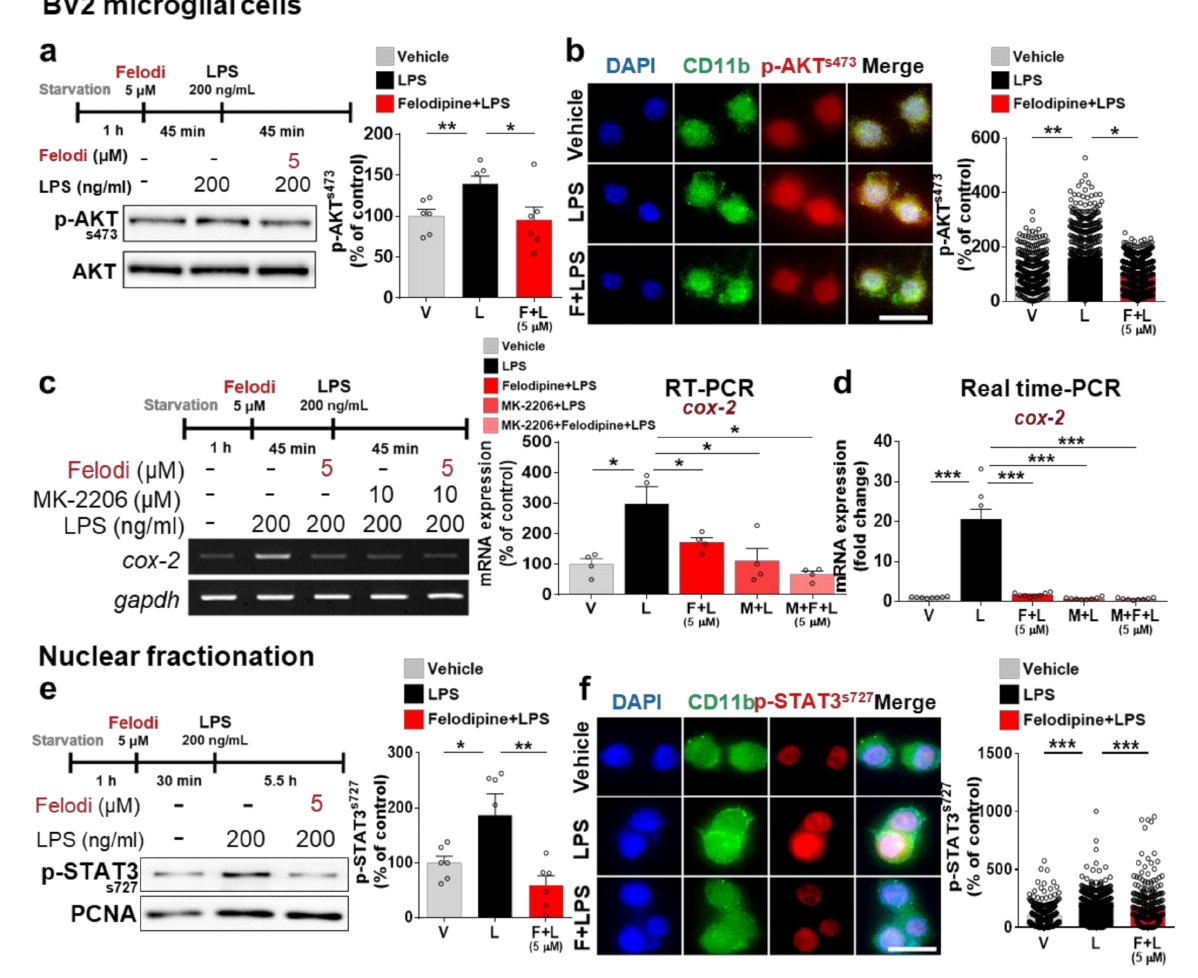
Figure 3. Felodipine inhibits LPS-stimulated AKT and STAT3 phosphorylation in BV2 microglial cells. ( a ) Western blot analysis of AKT phosphorylation in cells treated with 5 µ M felodipine